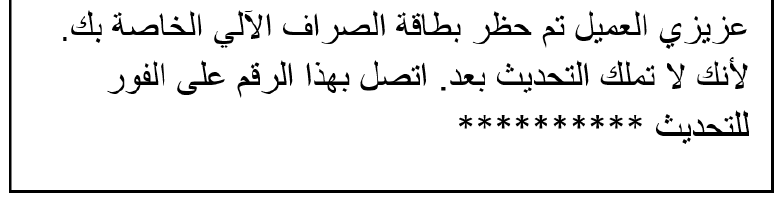
Figure 4. An example of an Arabic spam message. Table 2. Statistics of the